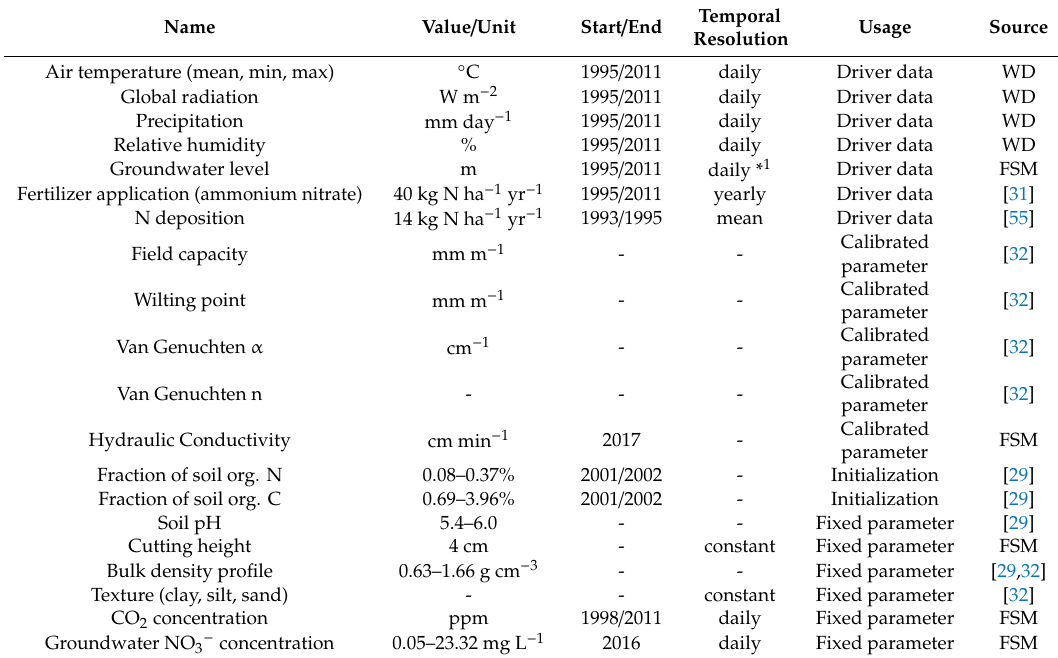
Table A1. Measured data implemented in LandscapeDNDC: FSM = field site measurements (see Section 2.1); WD = weather data [54]; variable = soil moisture, CO 2 and N 2 O emissions measurements ranged from several per week to several per